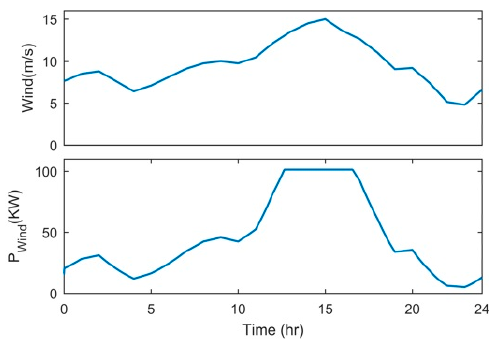
Figure 10. Performance of the wind energy system.